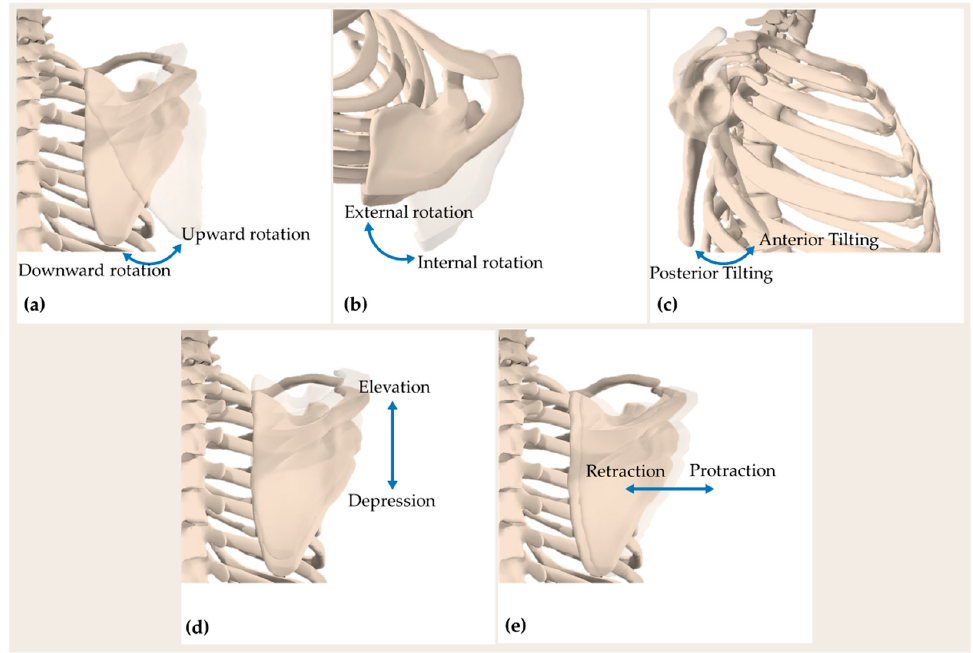
Figure 1. Movements of the scapula: ( a ) posterior view showing scapula upward-downward rotation; ( b ) superior view showing scapula internal-external rotation; ( c ) lateral view showing scapula anterior-posterior tilting; ( d ) posterior view showing scapula elevation-depression; and ( e ) posterior view showing scapula retraction-protraction. All representations refer to a right scapula.